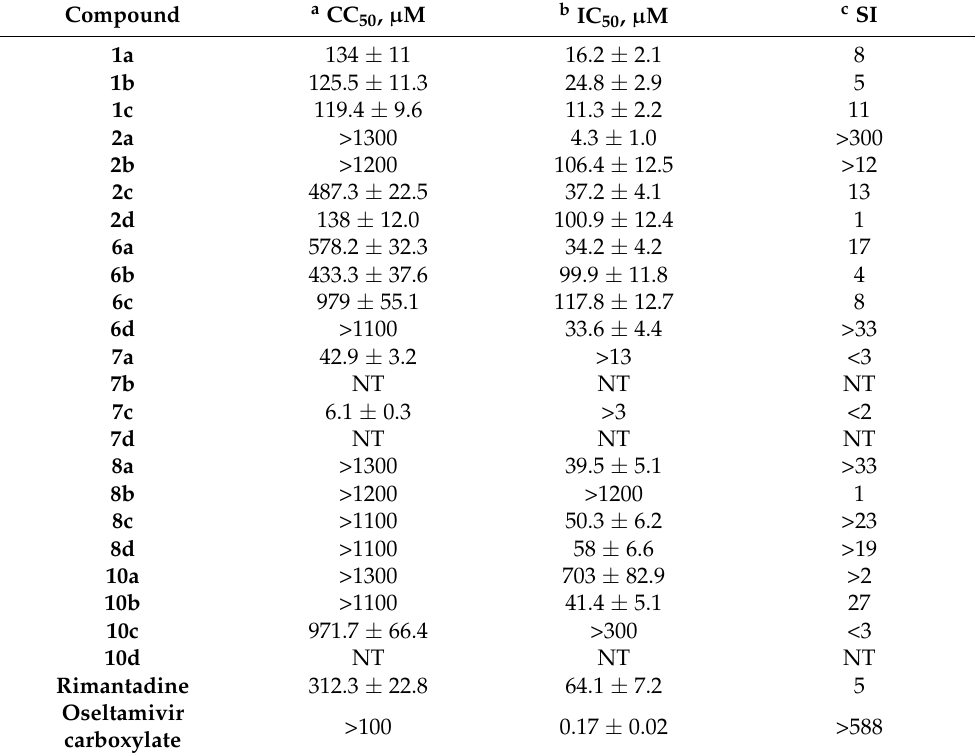
Table 2. Cytotoxic and anti-viral properties of synthesized compounds 1a–c , 2a–d , 6a–d , 7a–d , 8a–d , 10a–d according to in vitro tests against influenza virus A/Puerto Rico/8/34 in MDCK cells.